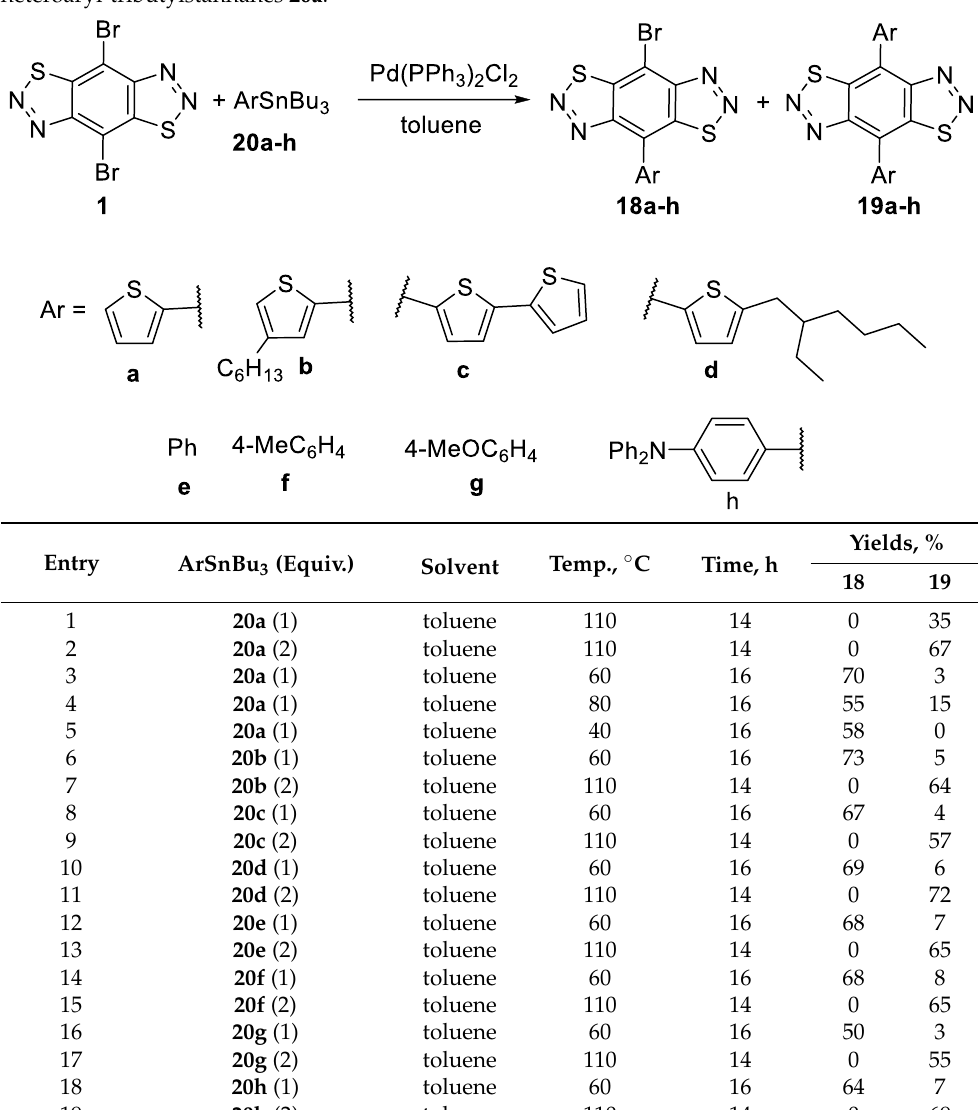
Table 6. Stille cross-coupling of 4,8-dibromobenzo[1,2- d :4,5- d ’]bis([1,2,3]thiadiazole) 1 with aryl- and heteroaryl-tributylstannanes 20a